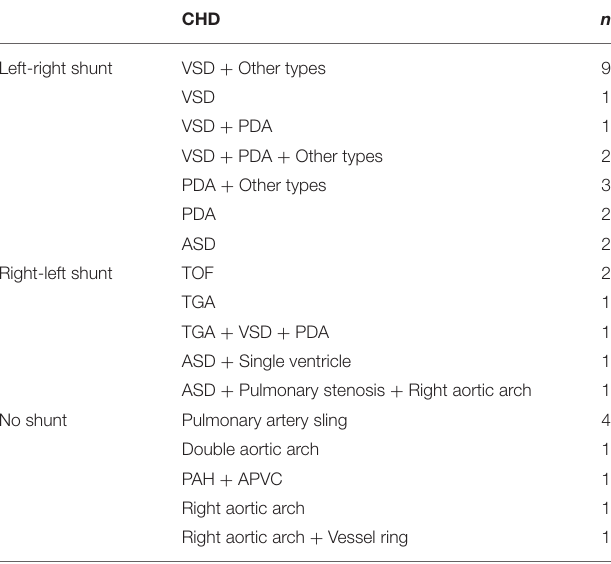
TABLE 4 | Types of congenital heart disease ( n =